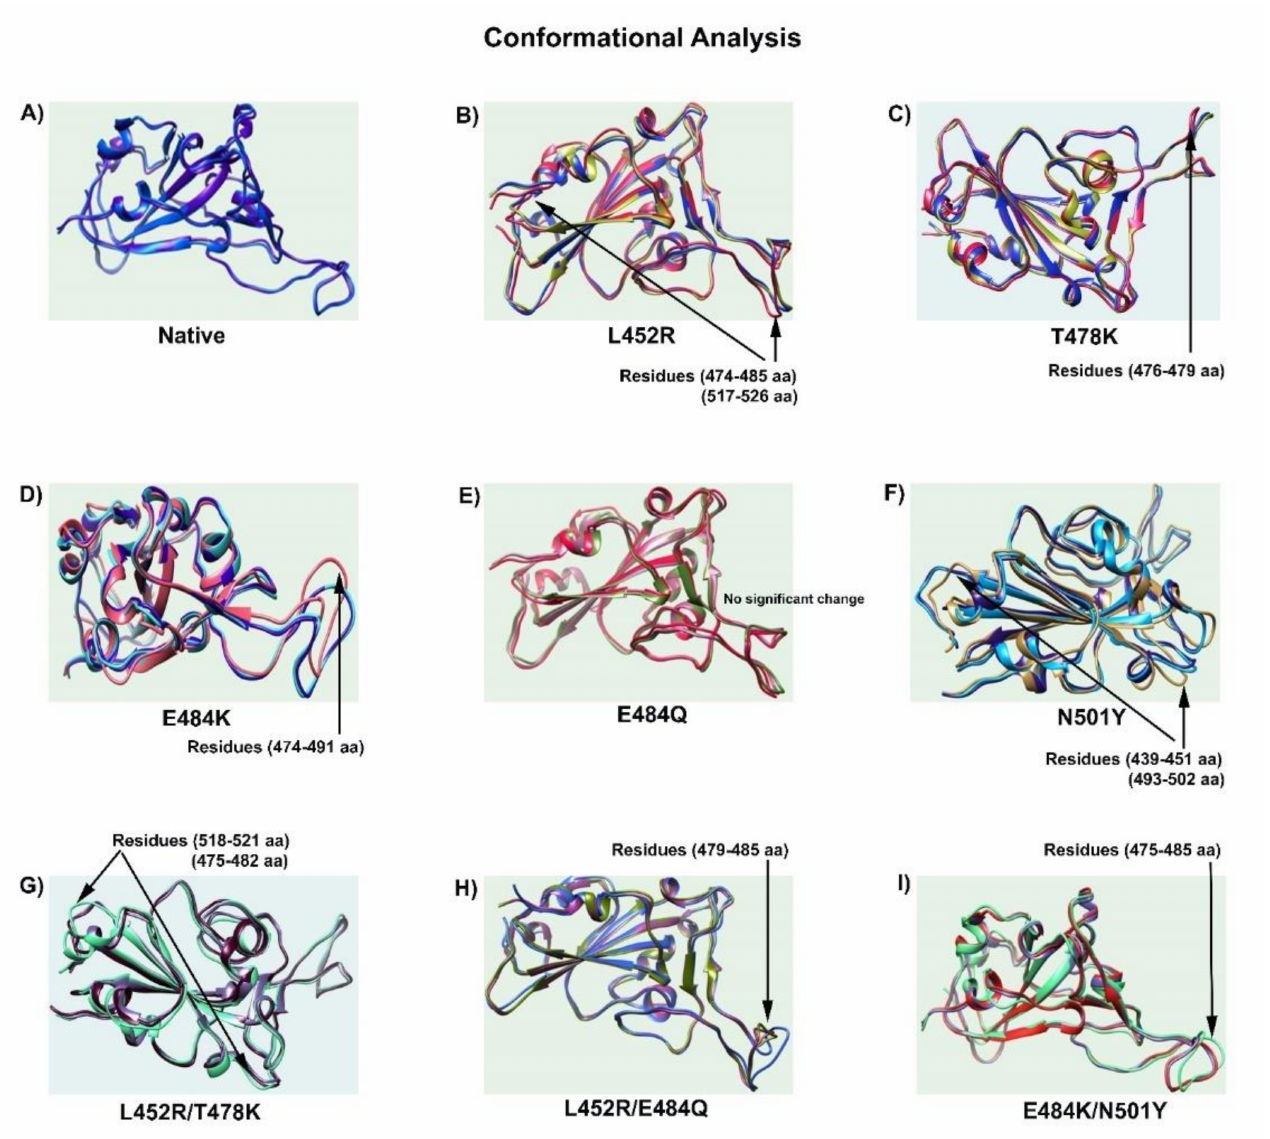
Figure 3. Conformational changes in mutated RBD. Mutant structures were superimposed with the wild-type RBD. Arrows show conformation changes at specific residue positions. ( A ) Native; ( B ) L452R; ( C ) T478K; ( D ) E484K; ( E ) E484Q; ( F ) N501Y; ( G ) L452R/T478K; ( H ) L452R/E484Q; ( I ) E484K/N501Y. The results show that the RBD conformational changes in double mutations were substantially different from single